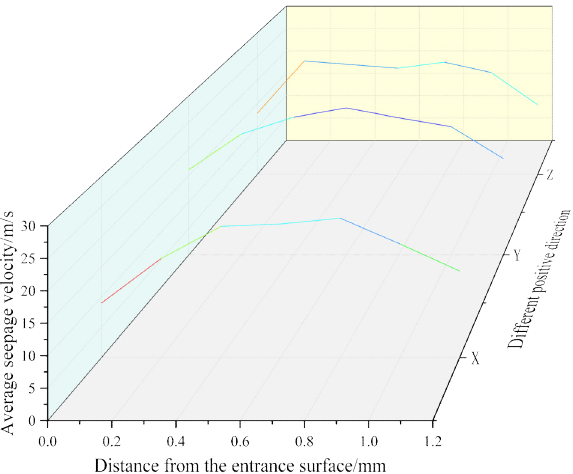
Figure 15. Curves of mean pressure at different cross-sections of X, Y, and Z seepage.